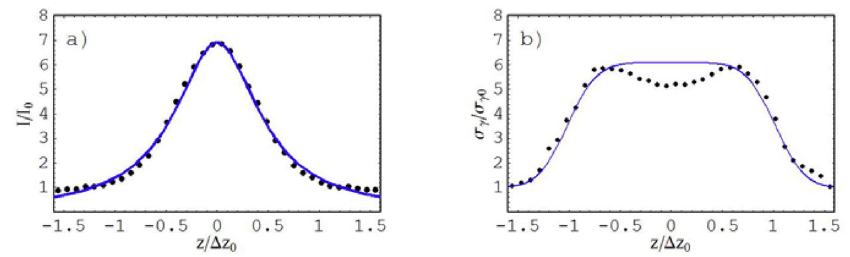
FIG. 3. (Color) Normalized peak current (a) and energy spread (b) versus distance within the microbunch. The dots show computer simulation results while the solid line was obtained with Eqs. (6) and